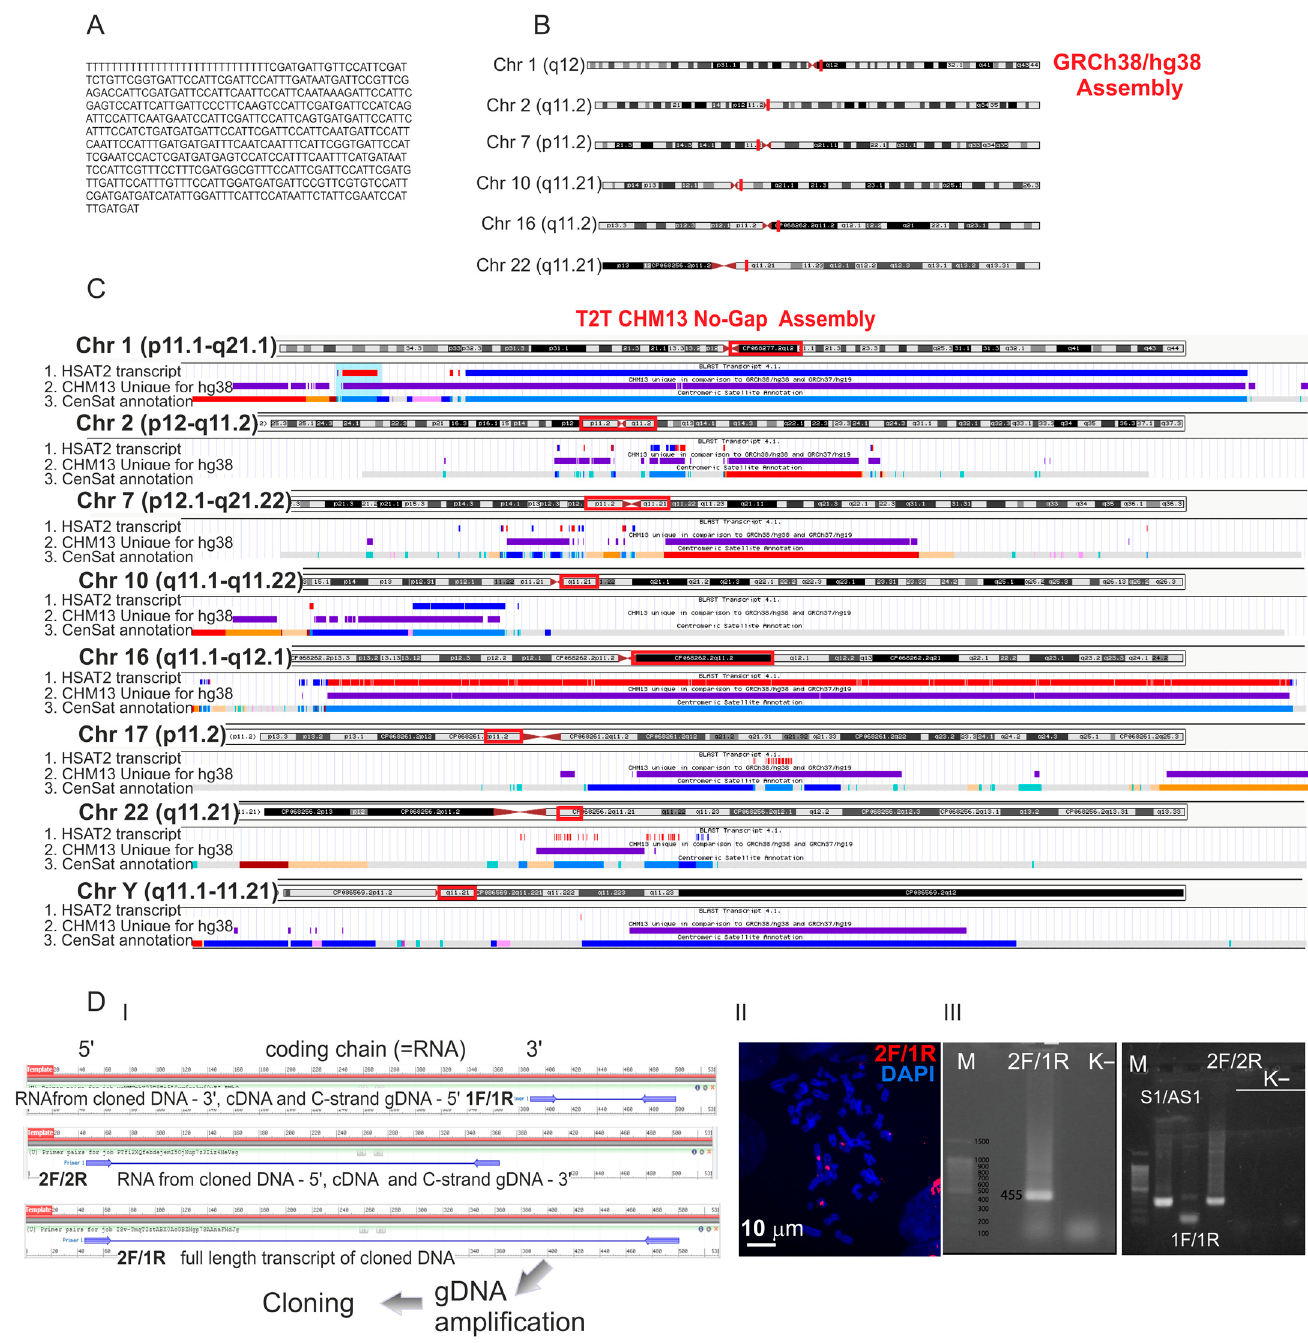
Figure 1. Mapping the transcript (Acc No TPA: BK063198): the sequence ( A ) annotated in [17] in the GRCh38/hg38 ( B ) and T2T-CHM13 ( C ) assemblies. ( B ) Localization of the transcript is shown as red lines on chromosome ideograms. ( C ) The transcript mapping is visualized in Genome Browser using the bed-files given in the Supplementary Materials (Supplementary File S1). Three tracks are shown: 1—the transcript track (red and blue—“+” and “–“ orientation of the repeated arrays of the sequence hits, respectively), 2—the track of sequences unique to T2T-CHM13 as compared to GRCh38/hg38, and 3—the track of satellite annotation in the T2T-CHM13 assembly. The colors in the third track are given according to the Centromeric Satellite Annotation colors in UCSC Genome browser. Active α Sat HOR (hor . . . L)—red, inactive α Sat HOR (hor)—orange, divergent α Sat HOR (dhor)—dark red, monomeric α Sat (mon)—peach/yellow, classical Human Satellite 1A (HSAT1A)—light green, Classical Human Satellite 1B (HSAT1B)—dark green, Classical Human Satellite 2 (hsat2)—light blue, Classical Human Satellite 3 (HSAT3)—blue, Beta Satellite (bsat)—pink, Gamma Satellite (gsat)—purple, other centromeric satellites (censat)—teal, centro ‐